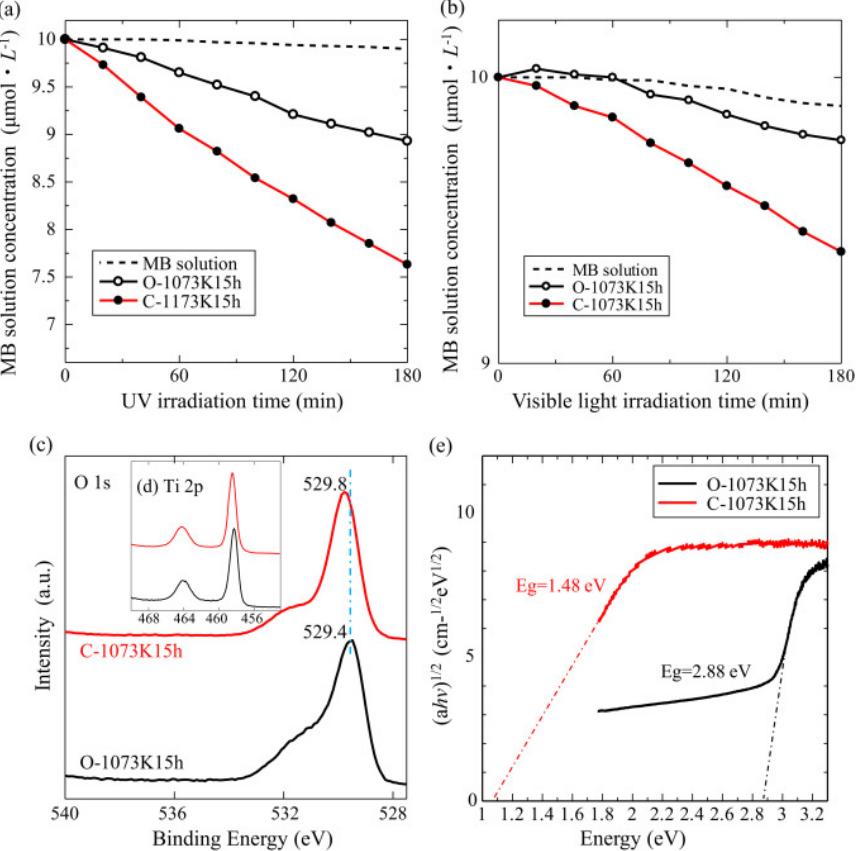
Figure 12. Photocatalytic behavior of TiC x O y coatings (prepared at carbon and air) over methylene blue degradation in the presence of ( a ) UV, and ( b ) Visible light; ( c , d ) XPS spectra for both TiC x O y coatings; ( e ) its band gap energies. Reproduced with permission [171], Copyright 2016, Elsevier.